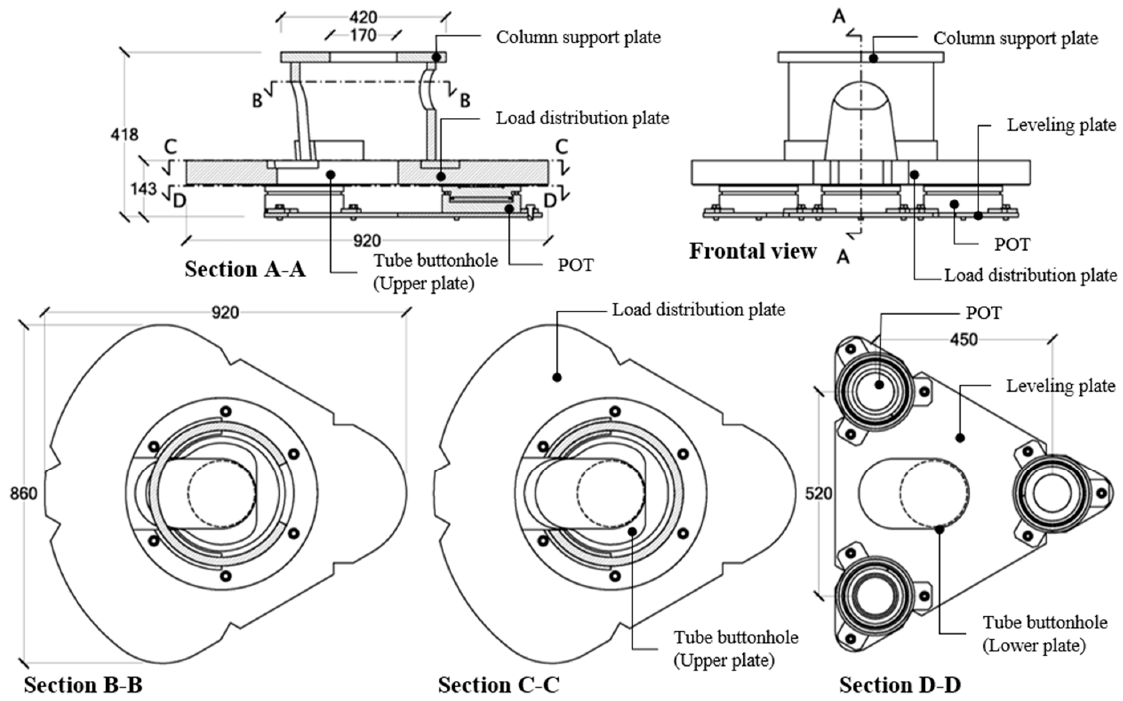
Figure 16. Technical drawings of the tripod, made during their design (all dimensions in mm).